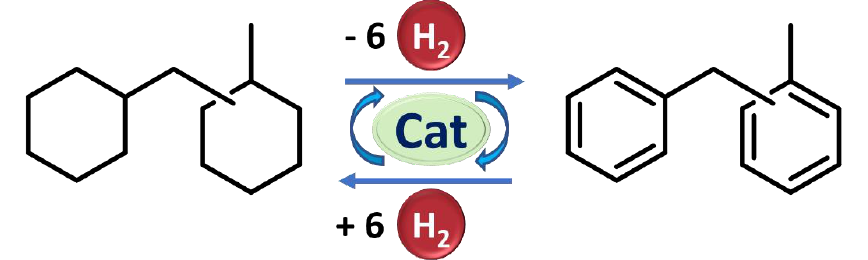
/ benzyl toluene LOHC